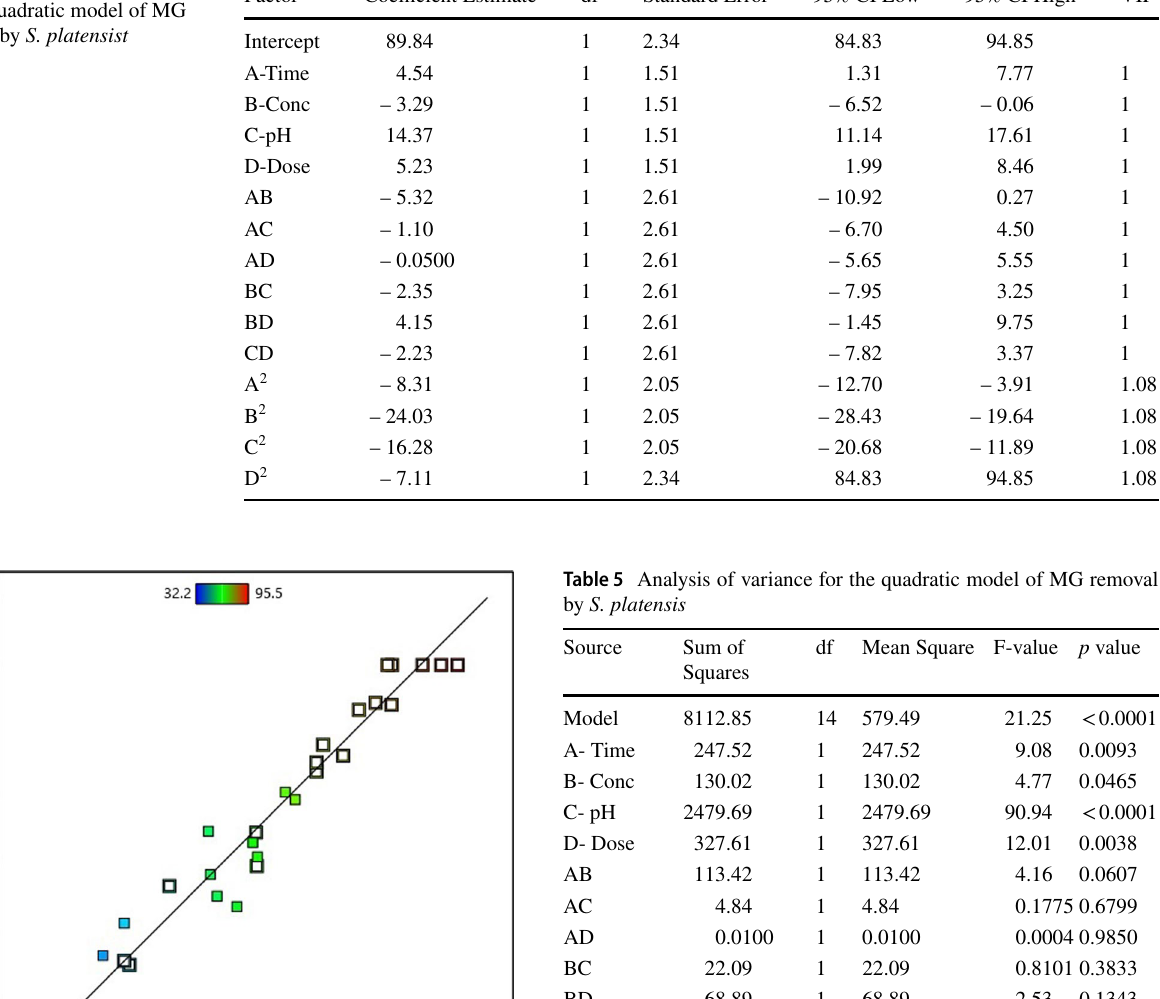
Table 4 Coefficients estimation for the quadratic model of MG removal by S. platensist